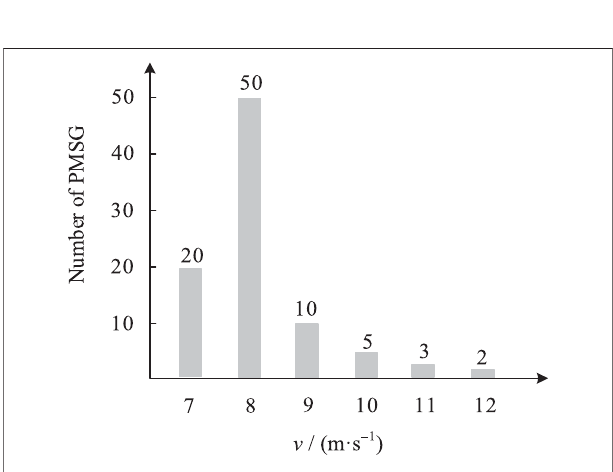
Frontiers in Energy Research |